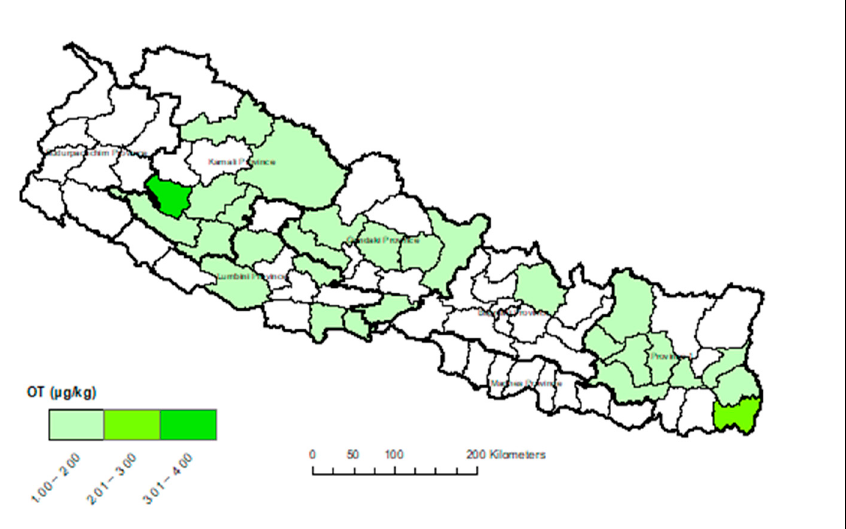
Figure A3. Heat map of OT occurrence in Nepalese maize. The range of found concentration of OT is shown in light green, green and dark green colors, representing the concentrations ranging from low to high. OT was found in concentrations of 1 to 3.22 µg/kg.